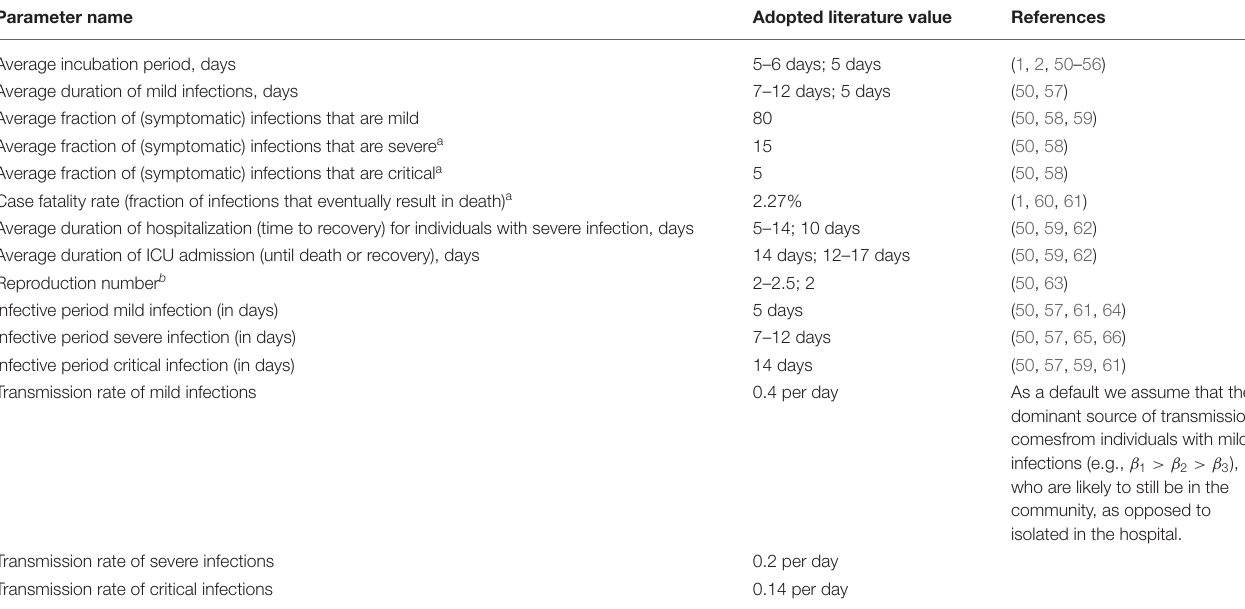
TABLE 2 | Adopted parameters for COVID-19 clinical progression based on literature sources.